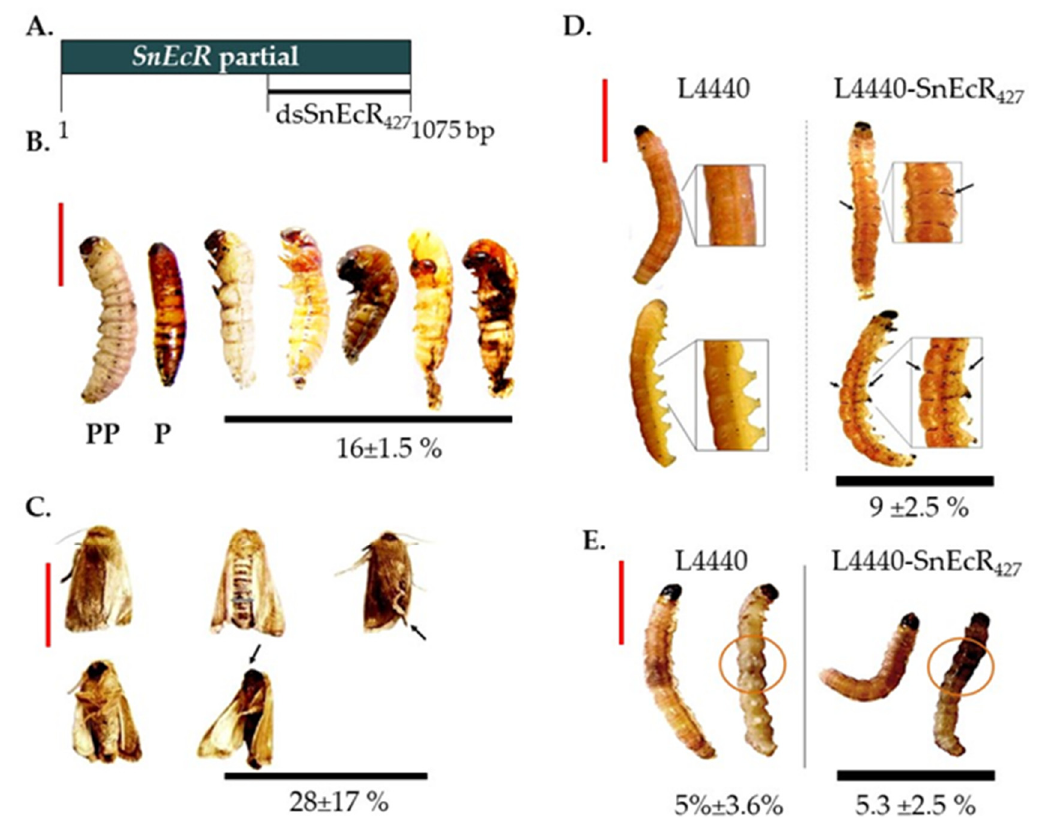
Figure 3. RNAi of EcR in S. nonagrioides . ( A ). Schematic representation of the partial cDNA sequence of the S. nonagrioides ecdysone receptor ( SnEc R) gene. The bar below the sequence indicates the fragment used for the synthesis of the dsEcR 427 . ( B ). Malformations of larval-pupal metamorphosis in EcRi S. nonagrioides insects injected at their prepupal stage. PP: Normal prepupae, P: Normal pupae. ( C ). Malformations in S. nonagrioides adults that were injected with 4 µg of dsEcR 427 as prepupae and underwent normal pupation (as shown in ( A )). Arrows indicate wing malformations and fused adult heads with pupal tissues. ( D ). Malformations of S. nonagrioides L5 larvae fed with the HT115/L4440:SnEcR 427 bacteria throughout their entire larval life. ( E ). Common developmental abnormalities between S. nonagrioides L5 larvae fed with the HT115/L4440::dsEcR 427 and HT115/L4440 bacteria throughout their entire larval life. Red bar indicates length equal to 1 cm.